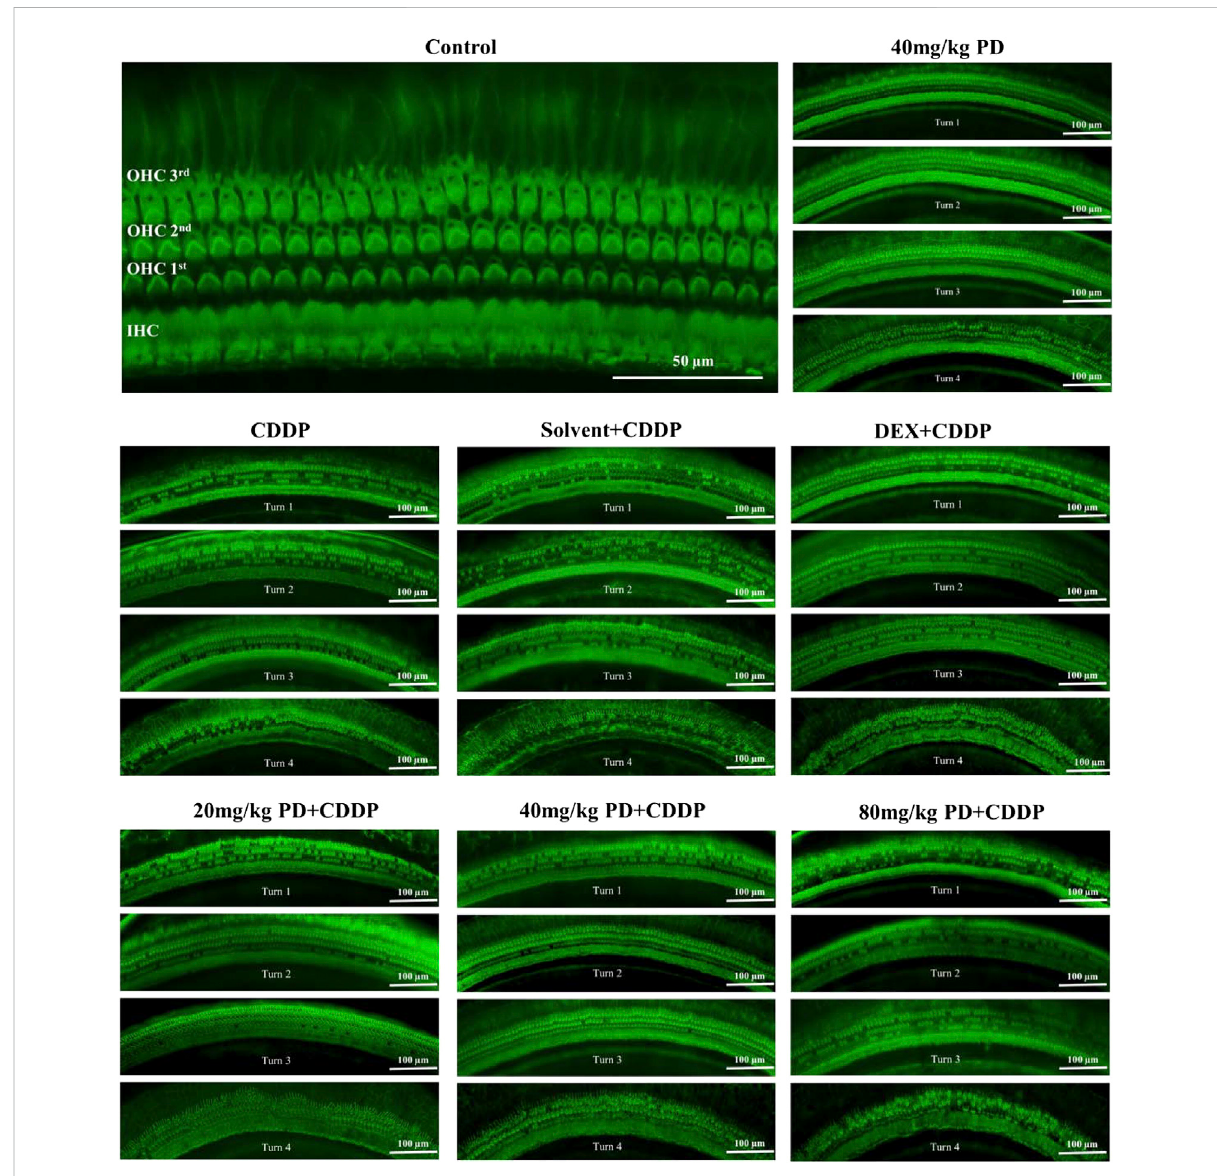
FIGURE 5 Survival of OHCs on the basilar membrane of each group after FITC-Phalloidin staining. In accordance with the SEM results, three layers of OHCsonbasilarmembranewerearrangedsuccessively,andtherewasanotherlayerofIHCsnearthecochlearaxis.SurvivingOHCsshowedagreen club-like structure, and the stereocilia on them showed a green-highlighted inverted V shape. Lost OHCs did not stain on the basilar membrane. In addition, no signi fi cant loss of IHCs was observed in all groups. n = 5. Scale bar, 50 μ m or 100 μ